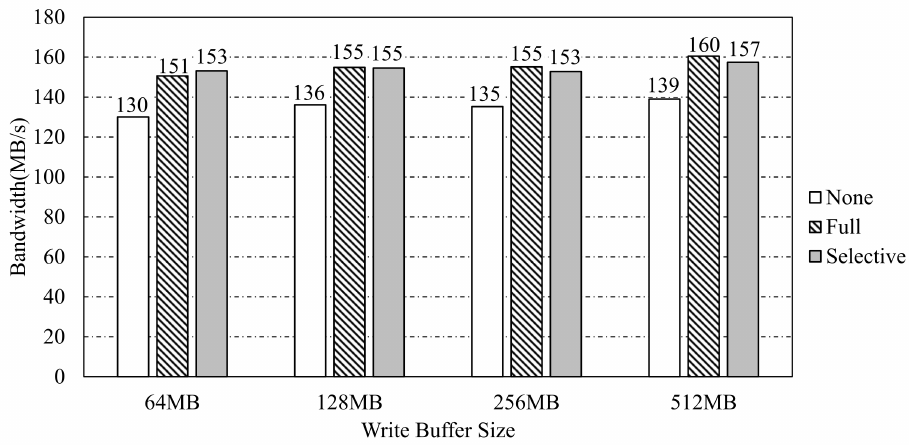
Figure 10. Performance evaluation results of fillseq workload with varying buffer size.